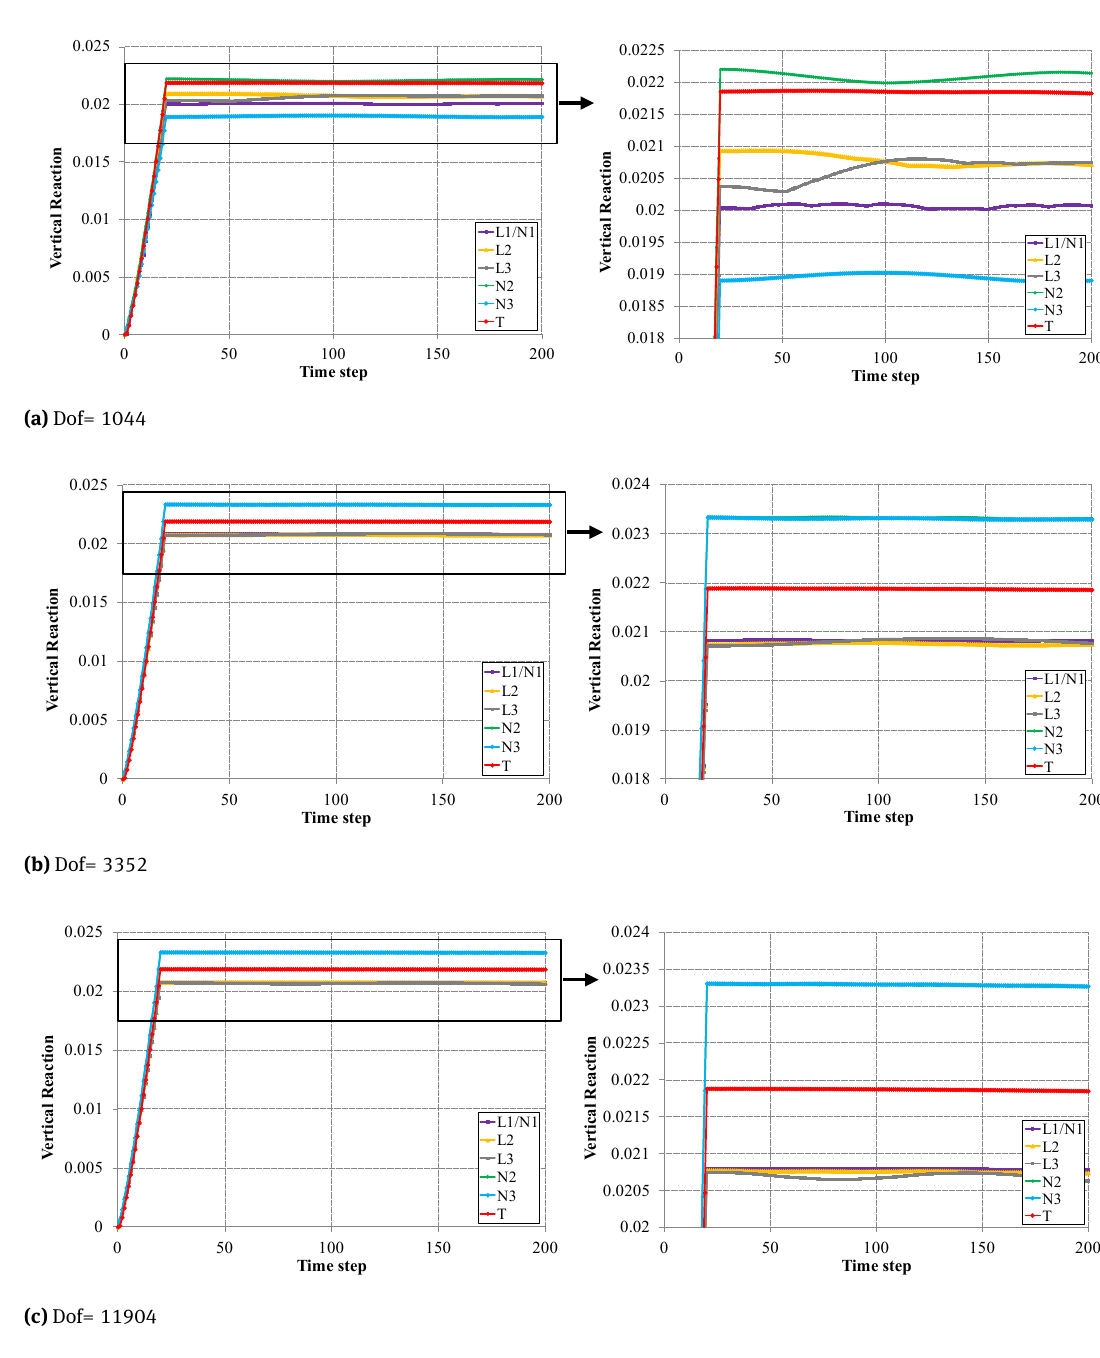
Figure 11: Ironing problem: vertical reaction-time